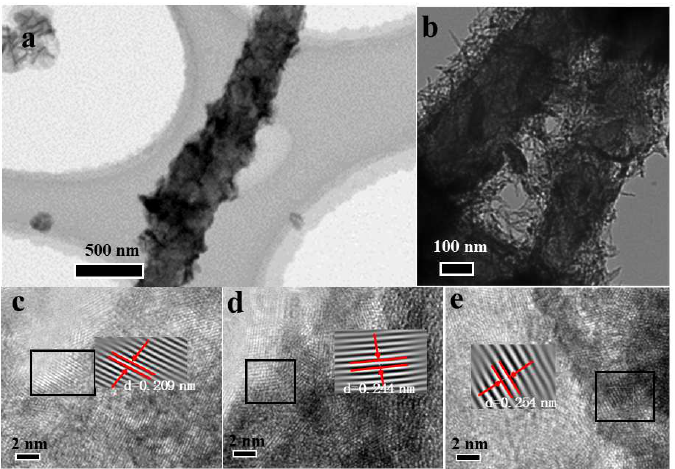
Figure 4. TEM pictures of CNFs@Ni(OH) 2 /NiO-250 ( a , b ).HRTEM pictures of CNFs@Ni(OH) 2 /NiO- 250 ( c – e ).